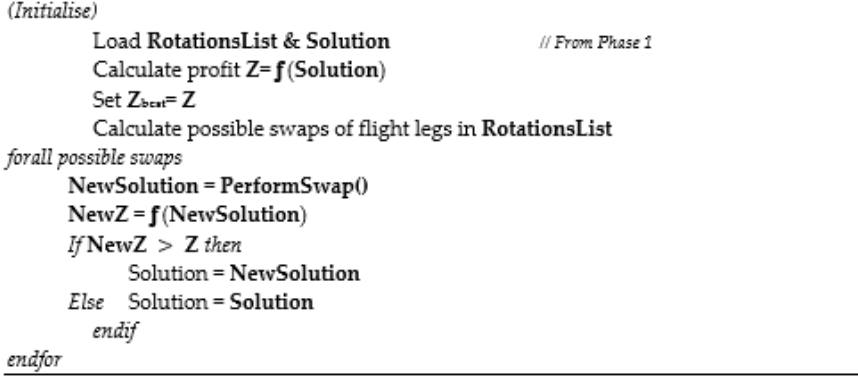
Figure 4. Detailed pseudocode for improvement (Phase 2) .